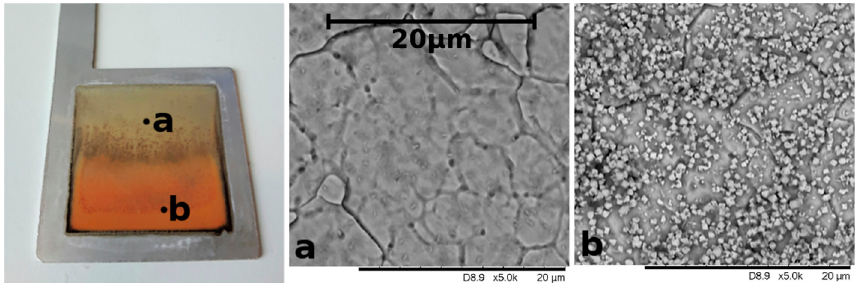
Figure 9. Electron micrographs at 5000x magnification of the stainless-steel cathode after Ageing Protocol B.